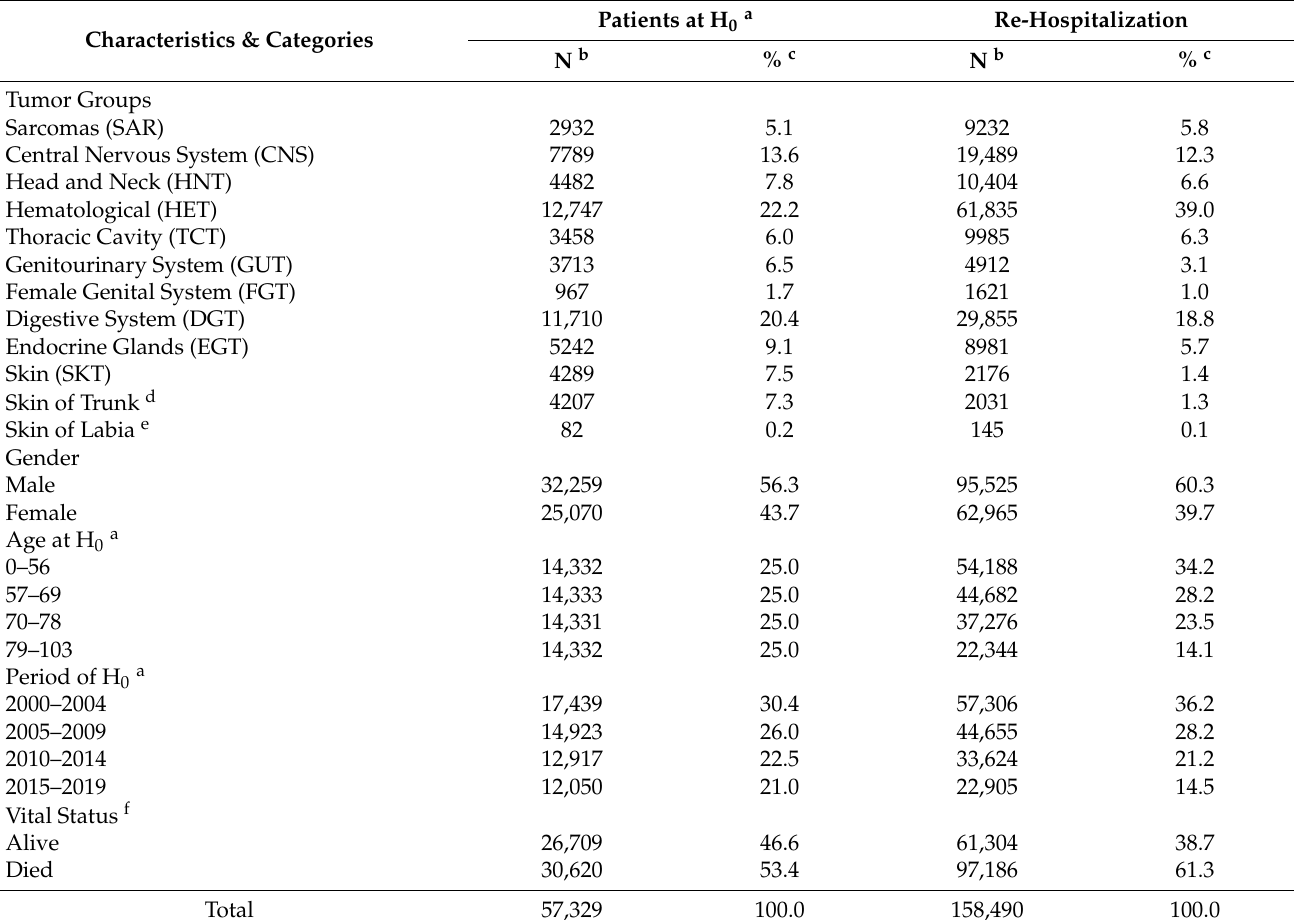
Table 1. Characteristics of patients with rare tumors in Liguria Region during